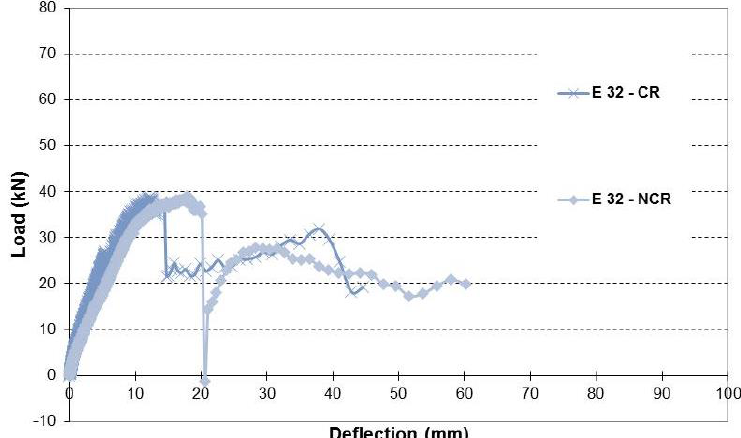
Figure 24. Load-deflection relationship of repaired beams with 20% corrosion level with and without cover.